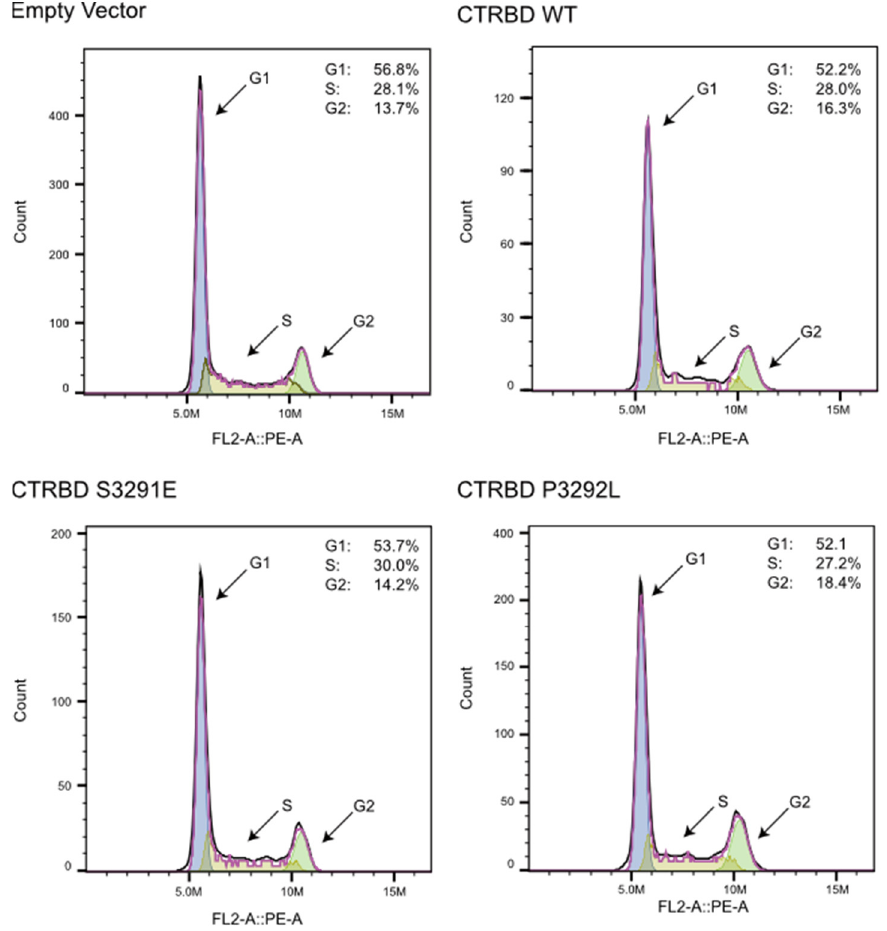
Figure 7. Cell cycle analysis of CTRBD-expressing cells. Flow cytometry histograms of cell populations of empty pOZ-N vector, wild-type, S3291E, and PS3292L mutant CTRBD (3260–3331 aa)-expressing cells in cell cycle phases. The percentage of each cell phase is indicated in the right upper space in each histogram.